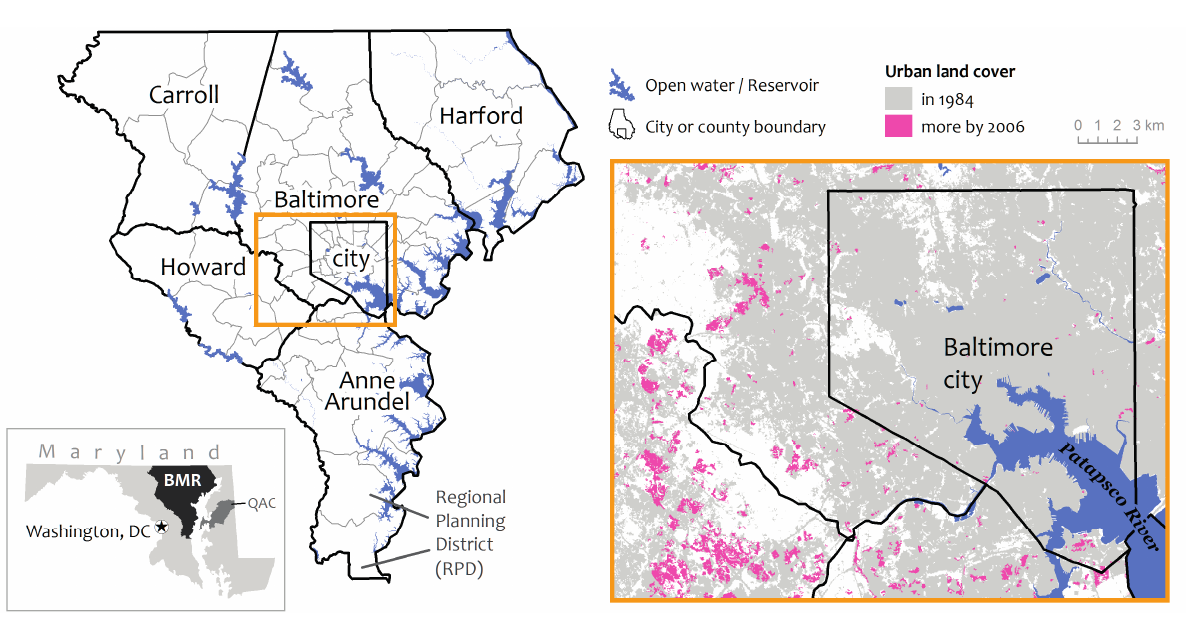
Figure 1. The modeled Baltimore Metropolitan Region (BMR) of adjacent county and county-equivalent areas, which does not include across-the-bay Queen Anne’s County (QAC). The highlighted region indicates the extent of urban land covers in 1984 and 2006.